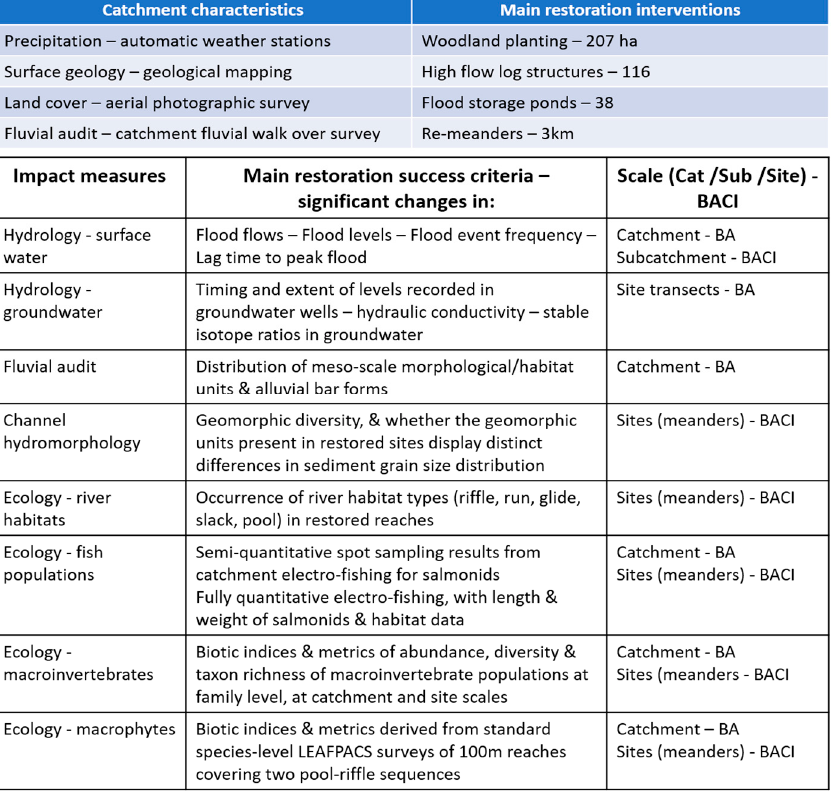
Figure 2. Eddleston Water Strategic Research Design. The methods used to determine restoration success, criteria chosen and scale of area covered are shown in Figures 3 and 4.